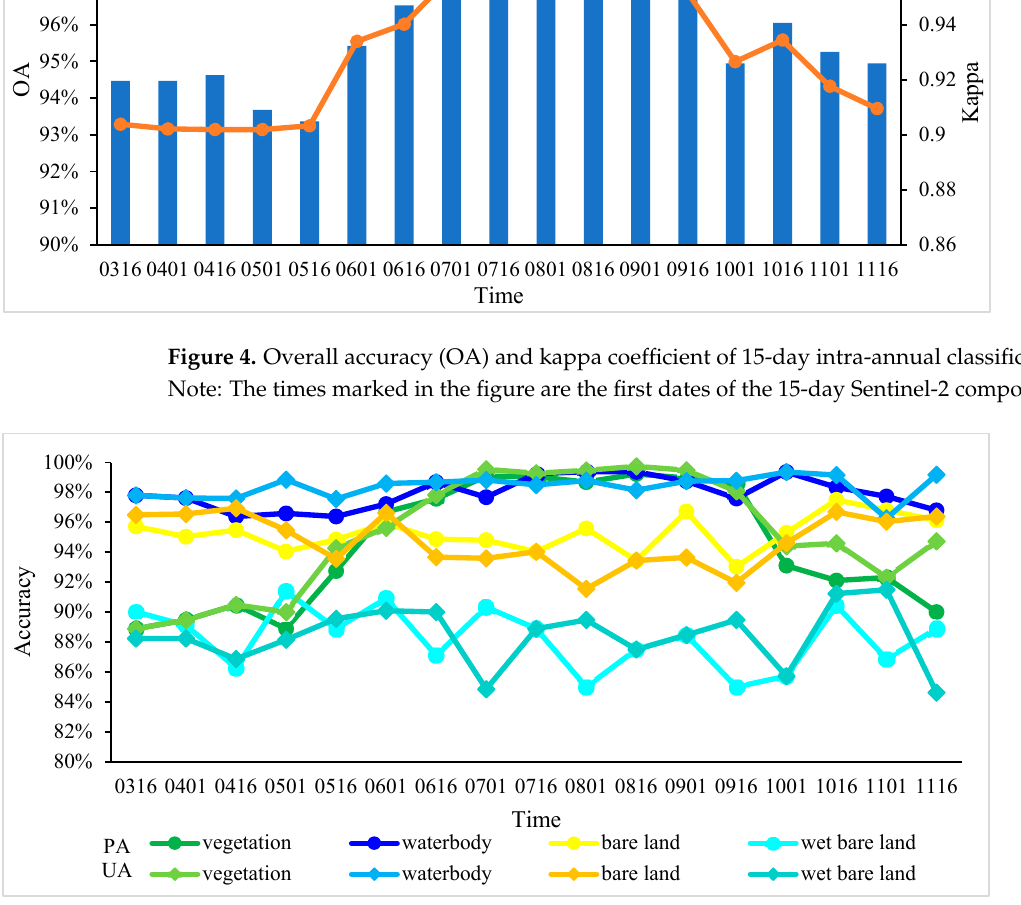
Figure 5. Producer accuracy (PA) and user accuracy (UA) of 15-day intra-annual classification results. Note: The times marked in the figure are the first dates of the 15-day Sentinel-2 composite